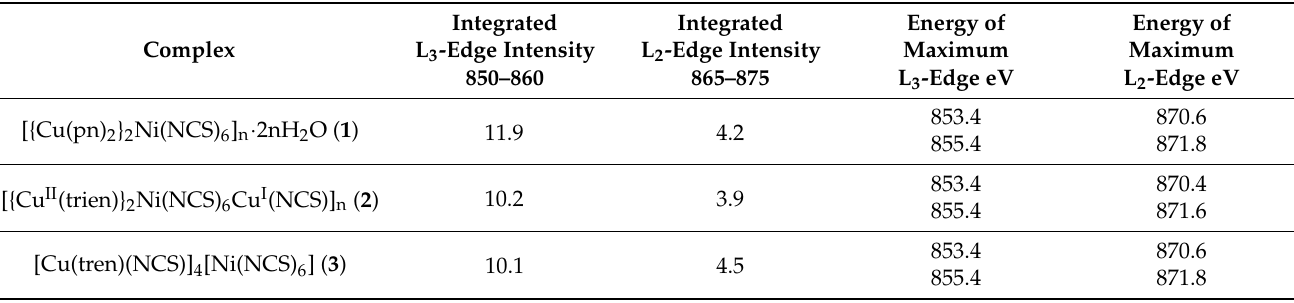
Table 6. Integrated intensities and energies of maximum for Ni L 3 -edge and L 2 -edge peaks for 1 , 2 and 3 .